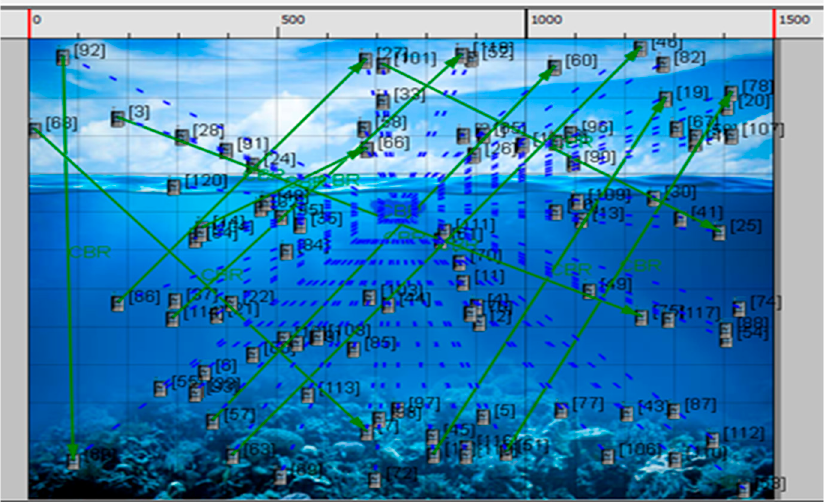
Figure 6. Proposed underwater wireless communication with 120 nodes in X-Y visualization .